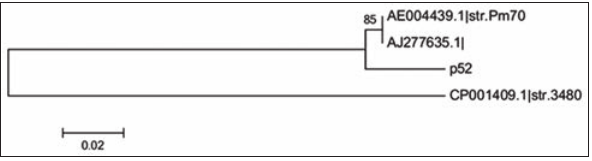
Figure-4: Phylogenetic tree based on nucleotide sequence illustrating the evolutionary relationship of hsf gene of P-52 strain with Pm70 (AE004439.1), 3480 strain (CP001409.1) of Pasteurella multocida and also with Haemophilus influenza (AJ277635.1). The phylogenetic tree was constructed using neighbor-joining analysis. Numbers represent bootstrap values (given as percentages) for a particular